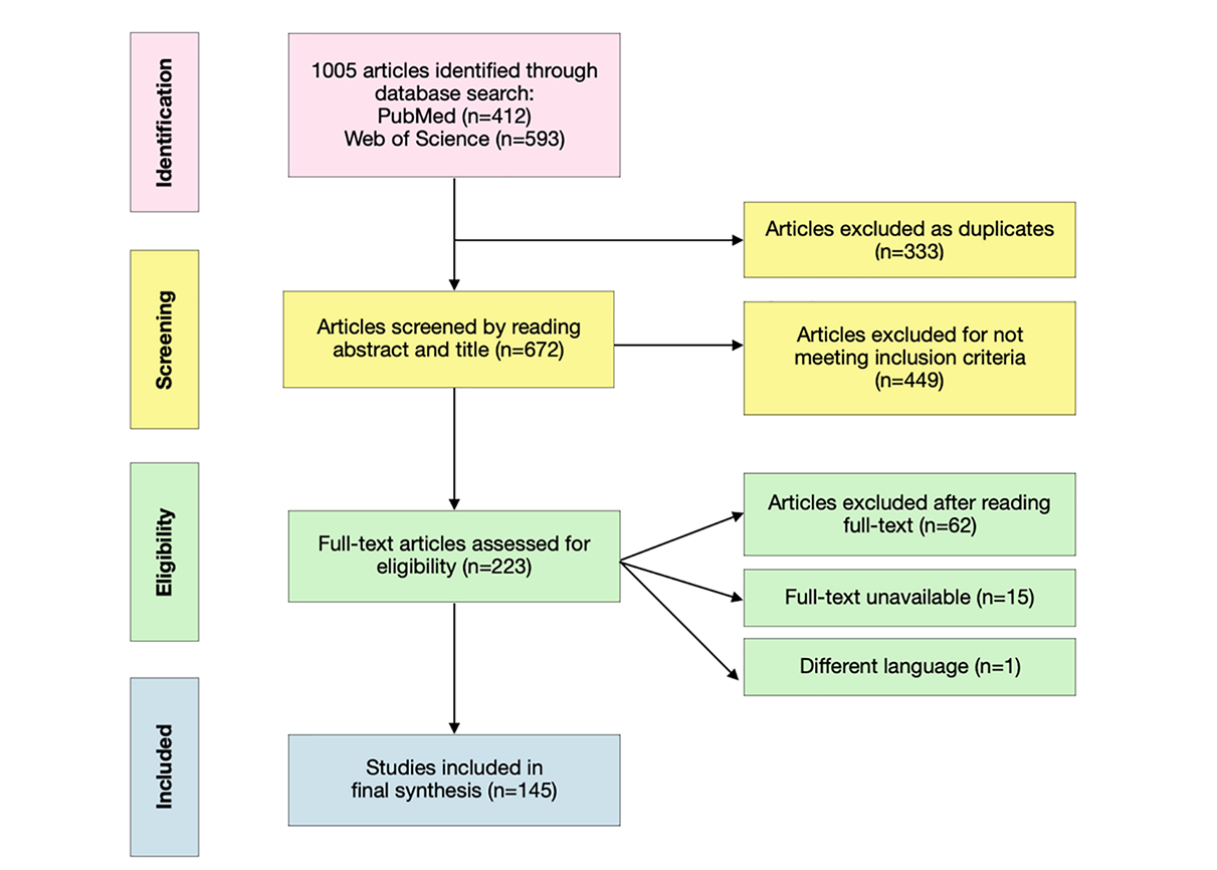
Figure 1. Flowchart of literature search and